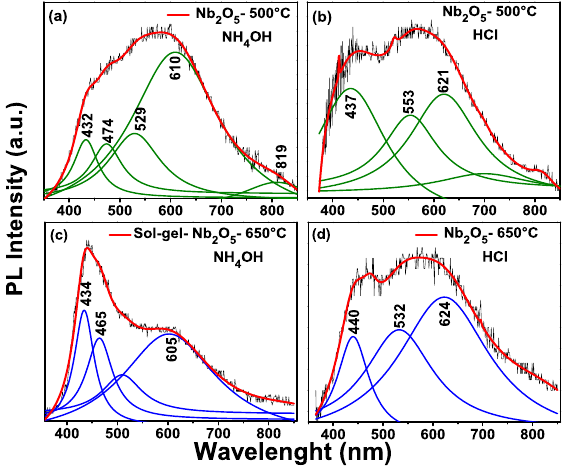
Figure 6. Photoluminescence spectra at room temperature: ( a ) Pechini (NH 4 OH) Nb 2 O 5 —500 ◦ C; ( b ) Pechini (HCl) Nb 2 O 5 —500 ◦ C; ( c ) Sol-gel (NH 4 OH) 650 ◦ C; and ( d ) Pechini (HCl) 650 ◦